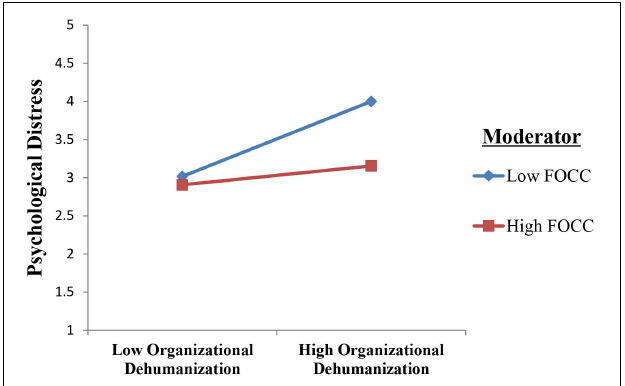
FIGURE 2 | Felt obligation for constructive change (FOCC) dampens the positive relationship between organizational dehumanization and psychological